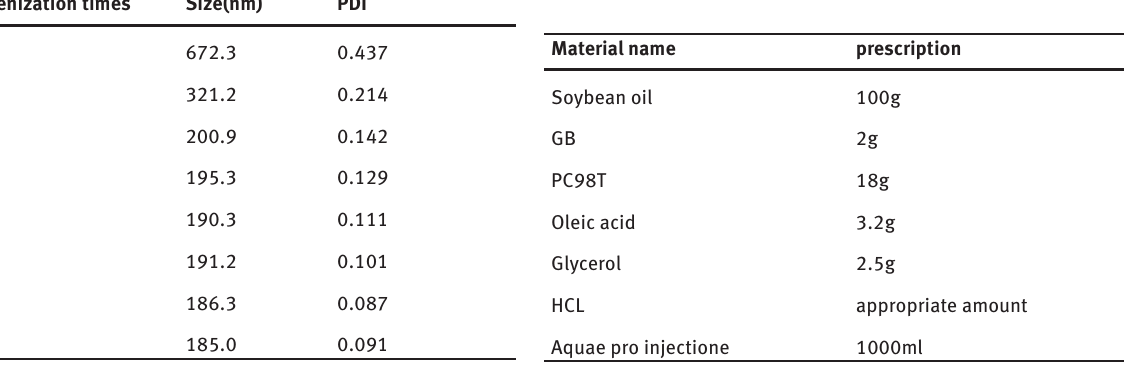
Table 6: Optimum formulation of